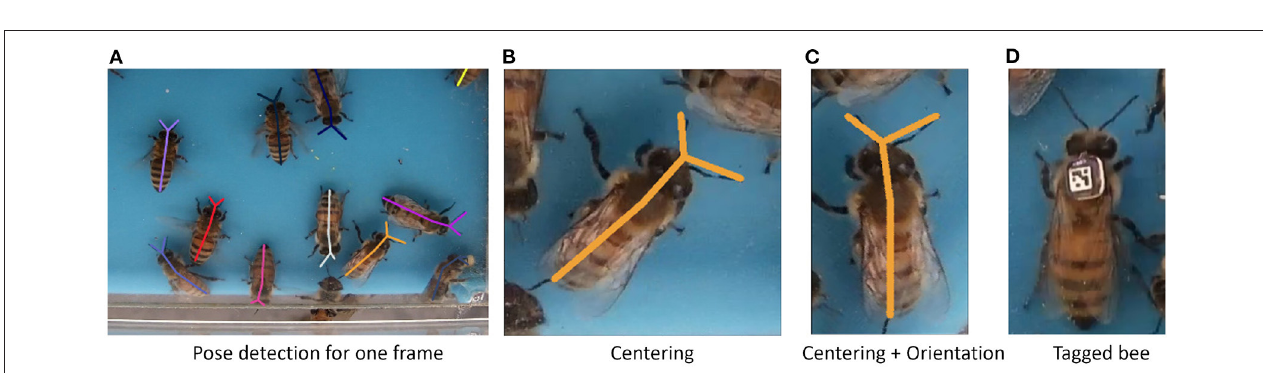
FIGURE 5 | Event classification policy based on trajectory endpoints. The entrance to the hive is at the top and the outside world is at the bottom. Red arrows represent exit events (leaving): these trajectories start inside the ramp and end below the threshold represented by the red line. Green lines represent entrances: these trajectories start at the bottom and end inside the ramp. Black lines represent ignored trajectories that are the result of tracking interruptions or of bees that dwell in a single area but never enter nor exit.